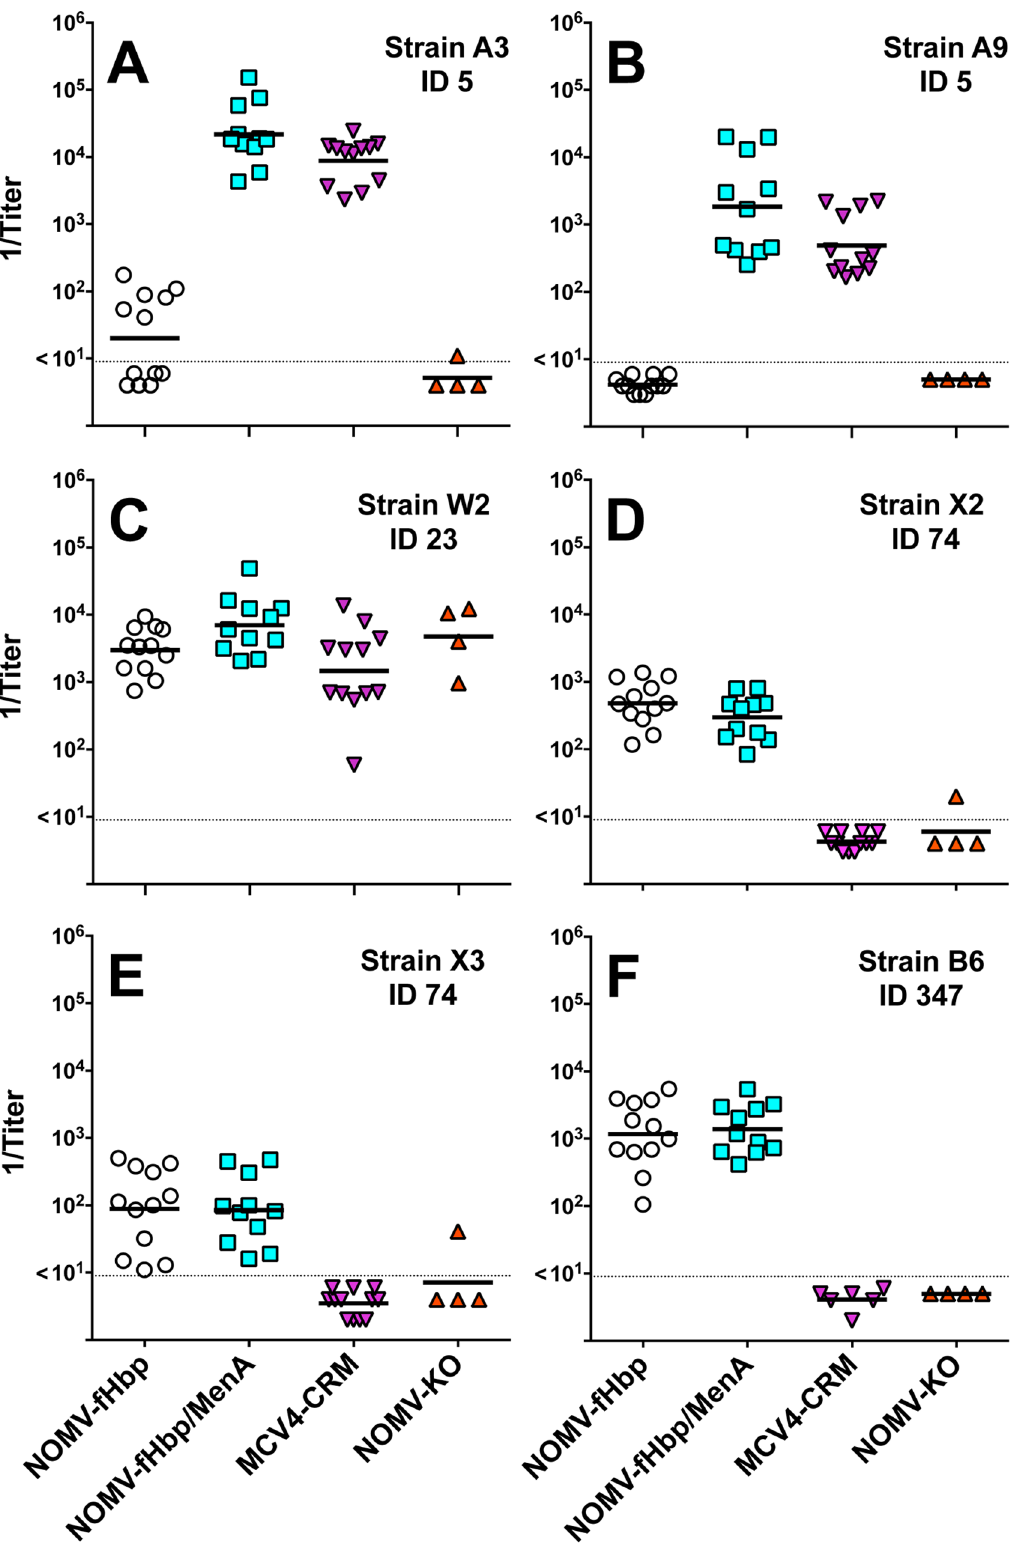
Figure 7. Serum bactericidal antibody responses of mice immunized with a combination NOMV-fHbp/MenA conjugate vaccine. Test strains are described in Table 1, and strain selection criteria are described in the text. Panels A and B, MenA strains A3 and A9 with fHbp ID 5, respectively in variant group 1. Panel C, MenW strain, W2, with fHbp ID 23 in variant group 2. Panels D and E, MenX strains, X2 or X3, respectively, with fHbp ID 74 in variant group 1. Panel F, MenB strain, B6, from The Gambia, with fHbp ID 347 in variant group 1. Each symbol represents the reciprocal titer of an individual mouse; horizontal bars represent 1/GMT. The respective serum bactericidal titers elicited by the combination NOMV-fHbp/MenA